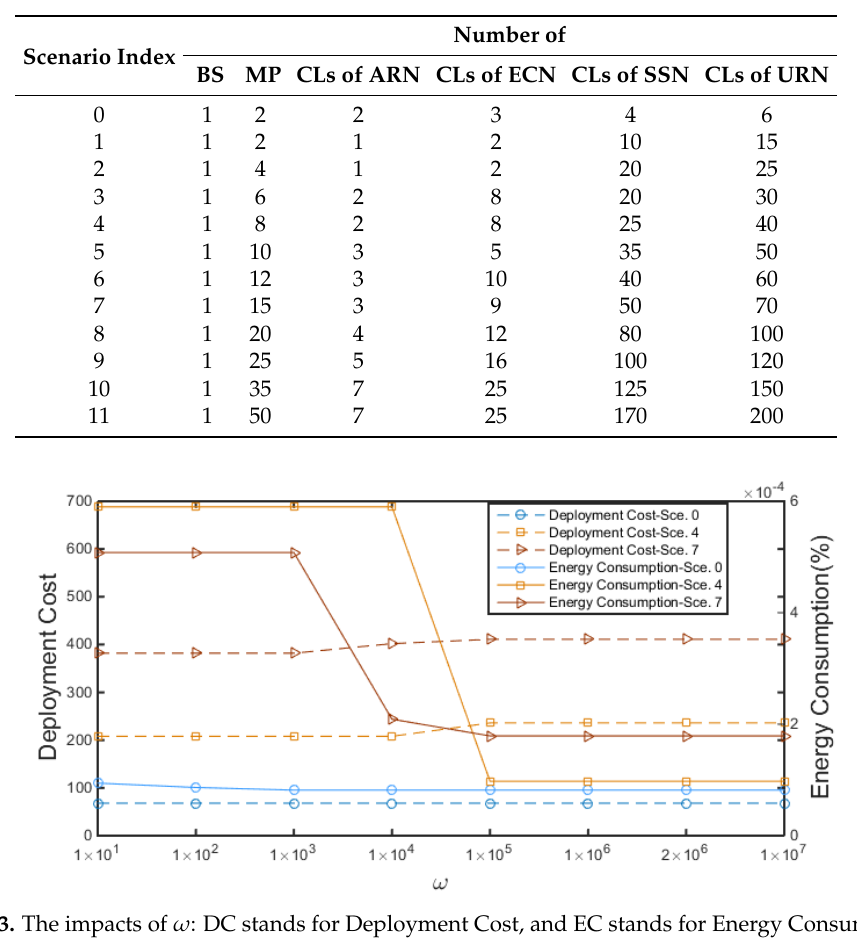
Table 2. The setting of simulated scenarios. CLs—Candidate Locations.